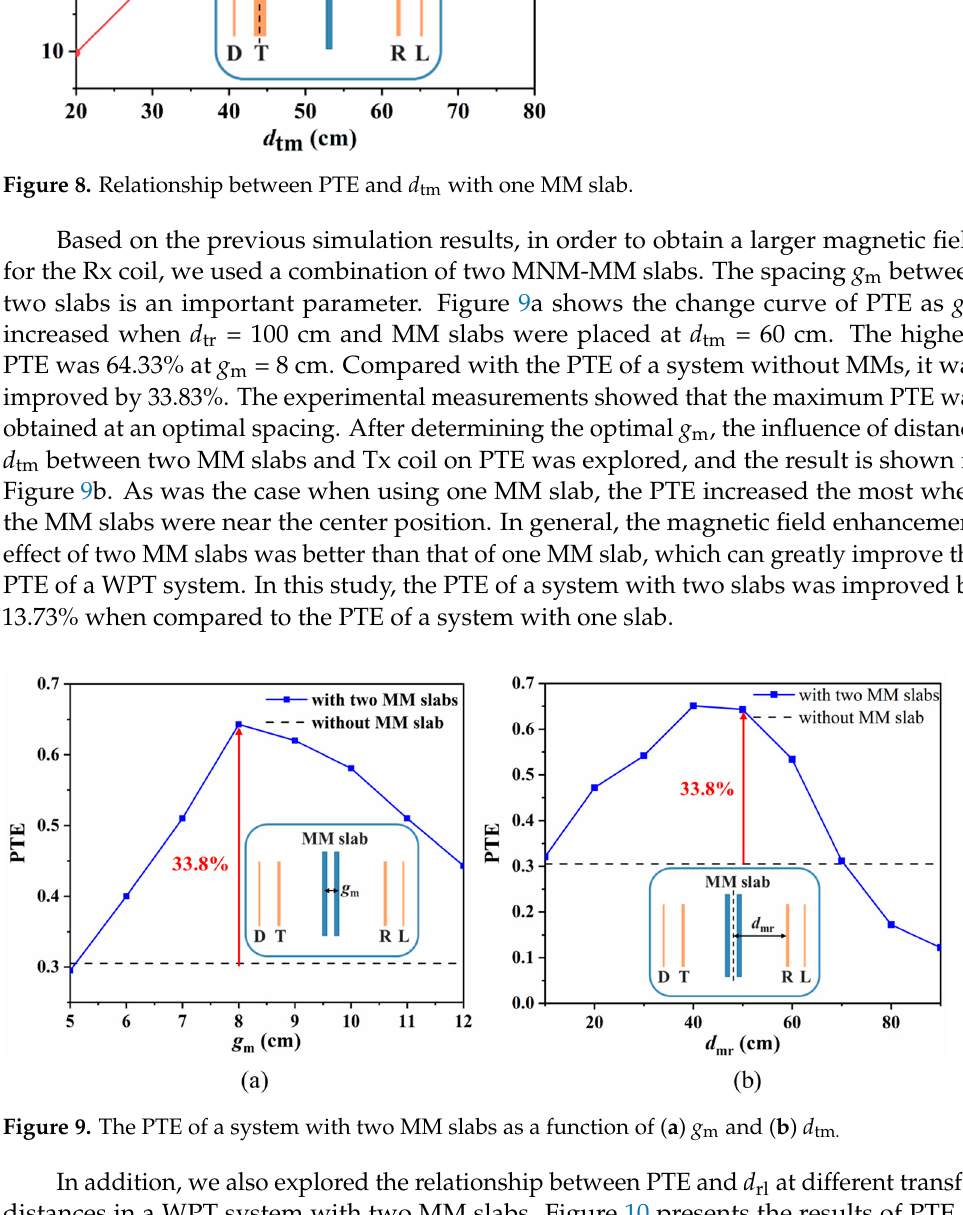
Figure 10. Measured PTE as a function of the d rl. According to the above experimental results, it can be concluded that the focusing magnetic field performance of MMs designed in this study was the best when d tr = 100 cm, g m = 8 cm and d tm = 60 cm. In order to install the coils on unmanned equipment more flexibly and conveniently, we integrated the load coil into the Rx coil. According to the optimal situation at d tr = 100 cm, the load coil was optimized to be a single loop with a di- ameter of 15 cm. It was coaxially placed on the acrylic plate of the Rx coil, as shown in Figure